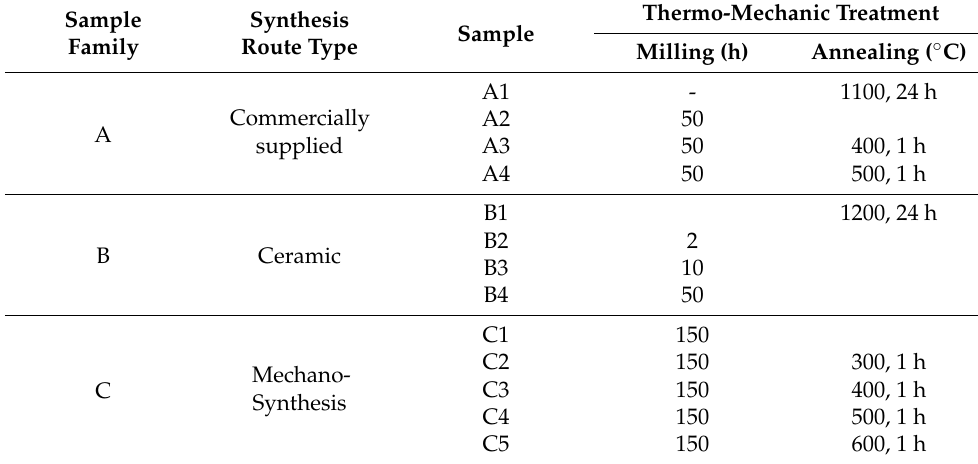
Table 1. Synthesis procedure for the different